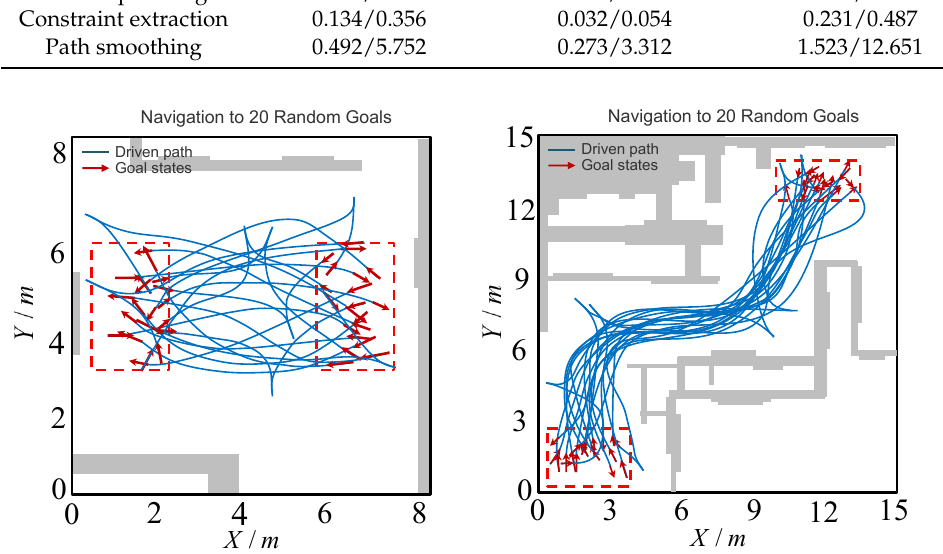
Figure 11. Random target selection. Left / Right : Path driven when navigating to 40 randomly chosen targets